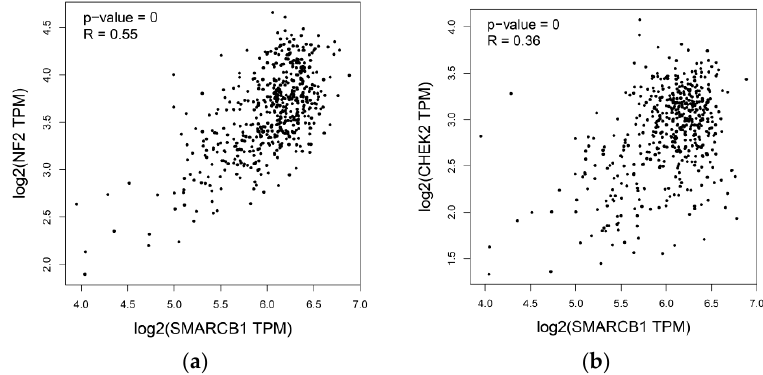
Figure 5. Associations of SMARCB1 expression levels and the expression of ( a ) NF2 and ( b ) CHEK2 in papillary thyroid cancer (THCA) dataset from The Cancer Genome Atlas (TCGA). These three genes are all located on chromosome 22q. TPM: transcripts per